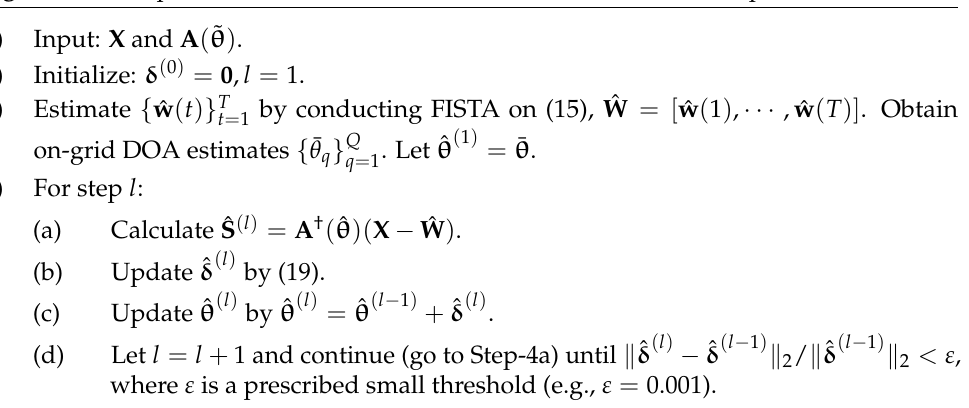
Algorithm 2 Proposed FISTA-based method for DOA estimation in impulsive